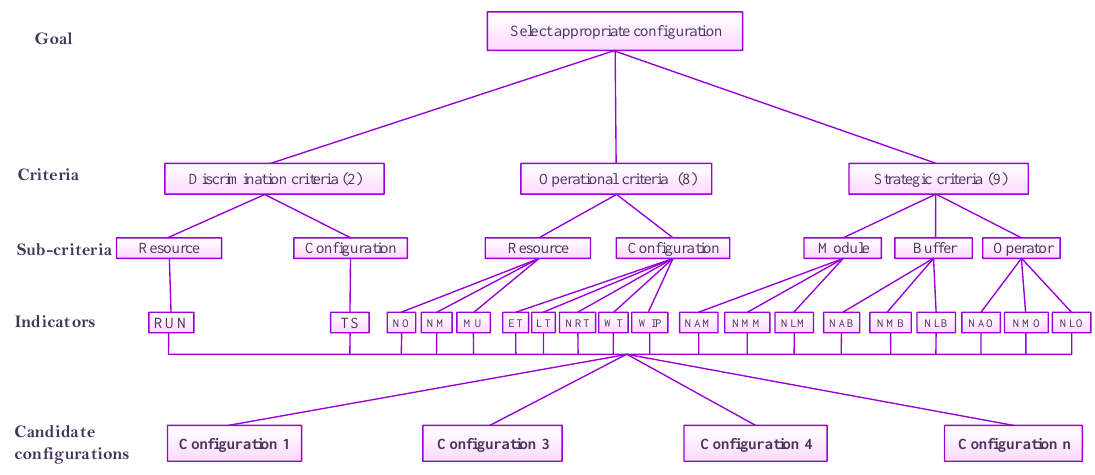
Figure 2. Evaluation criteria.